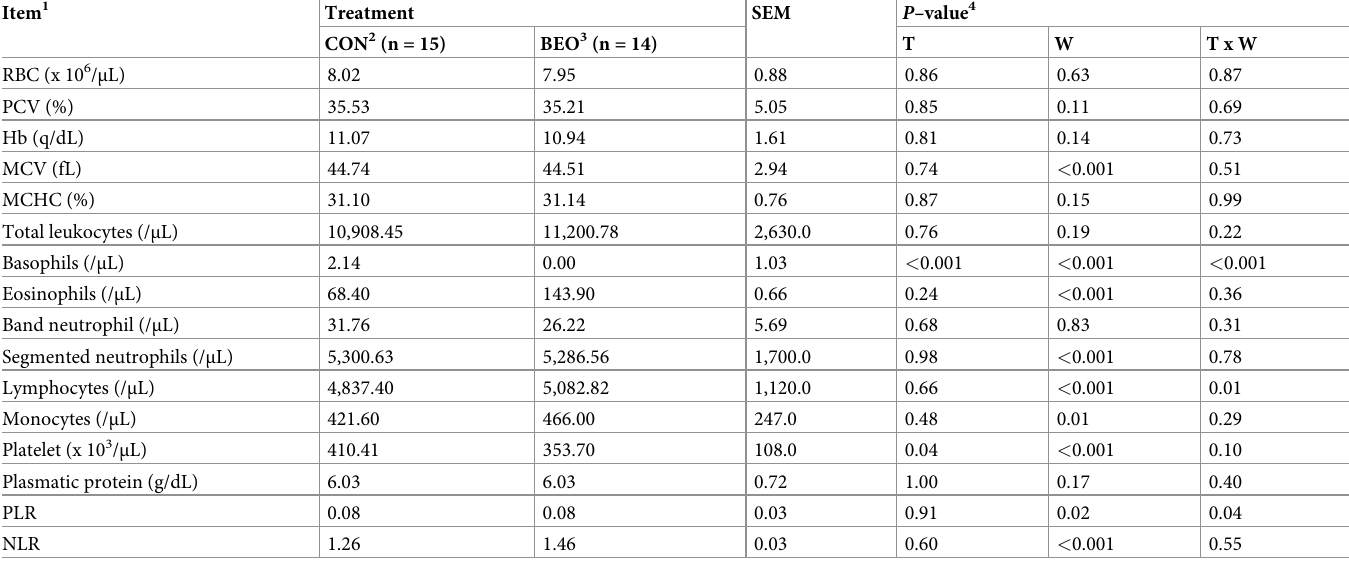
Table 6. Pre-weaning hematological parameters of control heifers (CON) and heifers supplemented with a blend of essential oils blend (BEO) in milk replacer dur- ing pre-weaning. Item 1